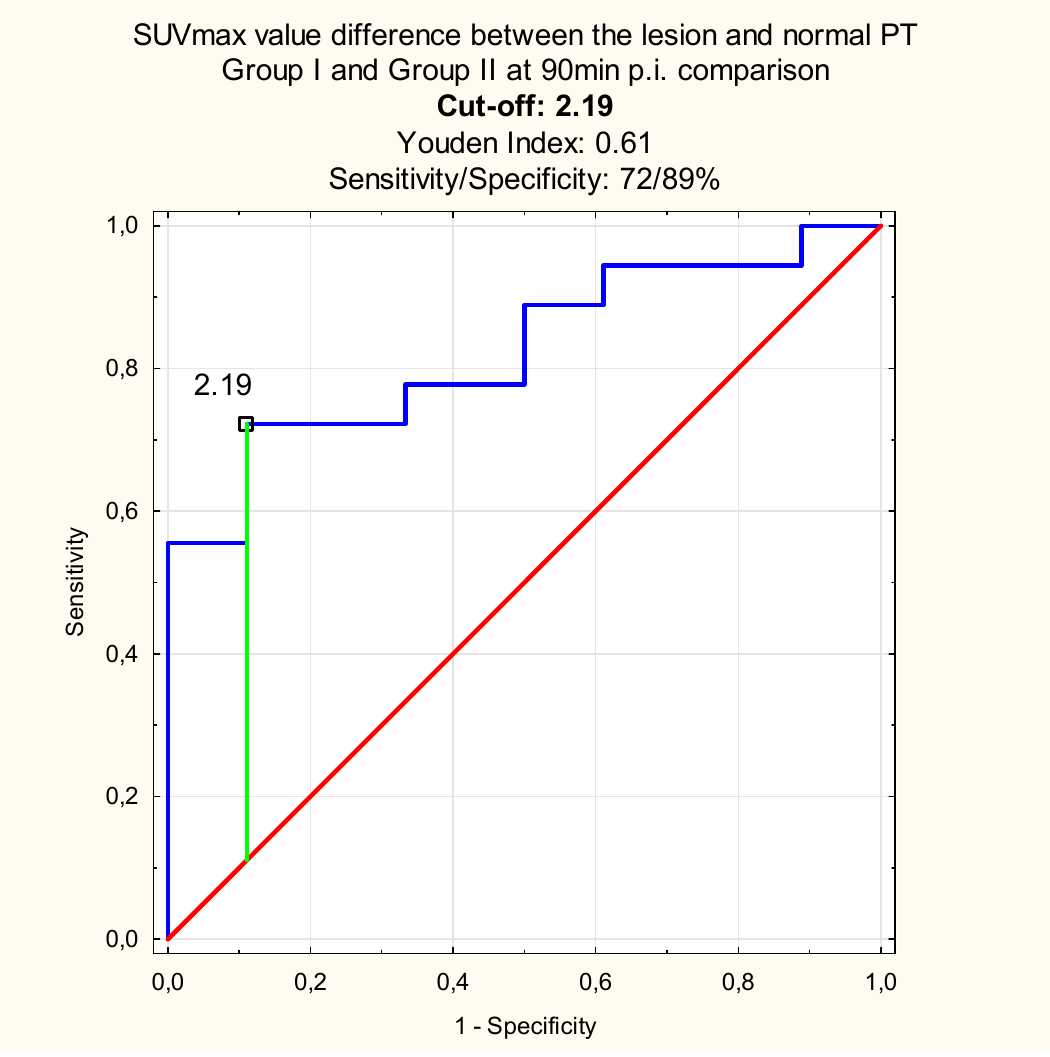
Figure 3. The SUVmax value difference between the lesion and normal PT which distinguishes inflammation and PT tumor at 90 min p.i. (blue line—sensitivity, red line—specificity, green—cut-off point). We did not compared the cut-o ff point di ff erentiating the inflammation and PT tumor based on the di ff erences between the normal and abnormal PTs as a demanding additional factor, indicating the relative SUVmax value di ff erence, obtained at 60 and 90 min p.i. Providing this factor would make the analysis confusing and possibly less reliable due to the necessity of using mean values on every step of the analysis, increasing the standard error in the